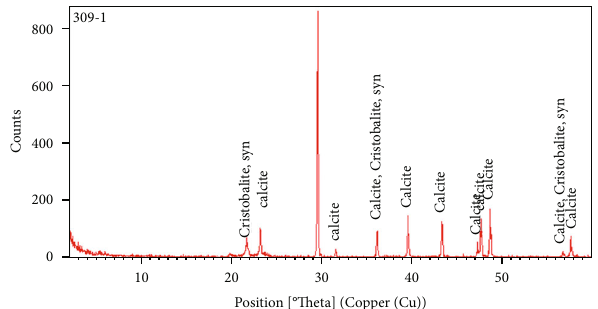
Figure 5: Mineralogical analysis of